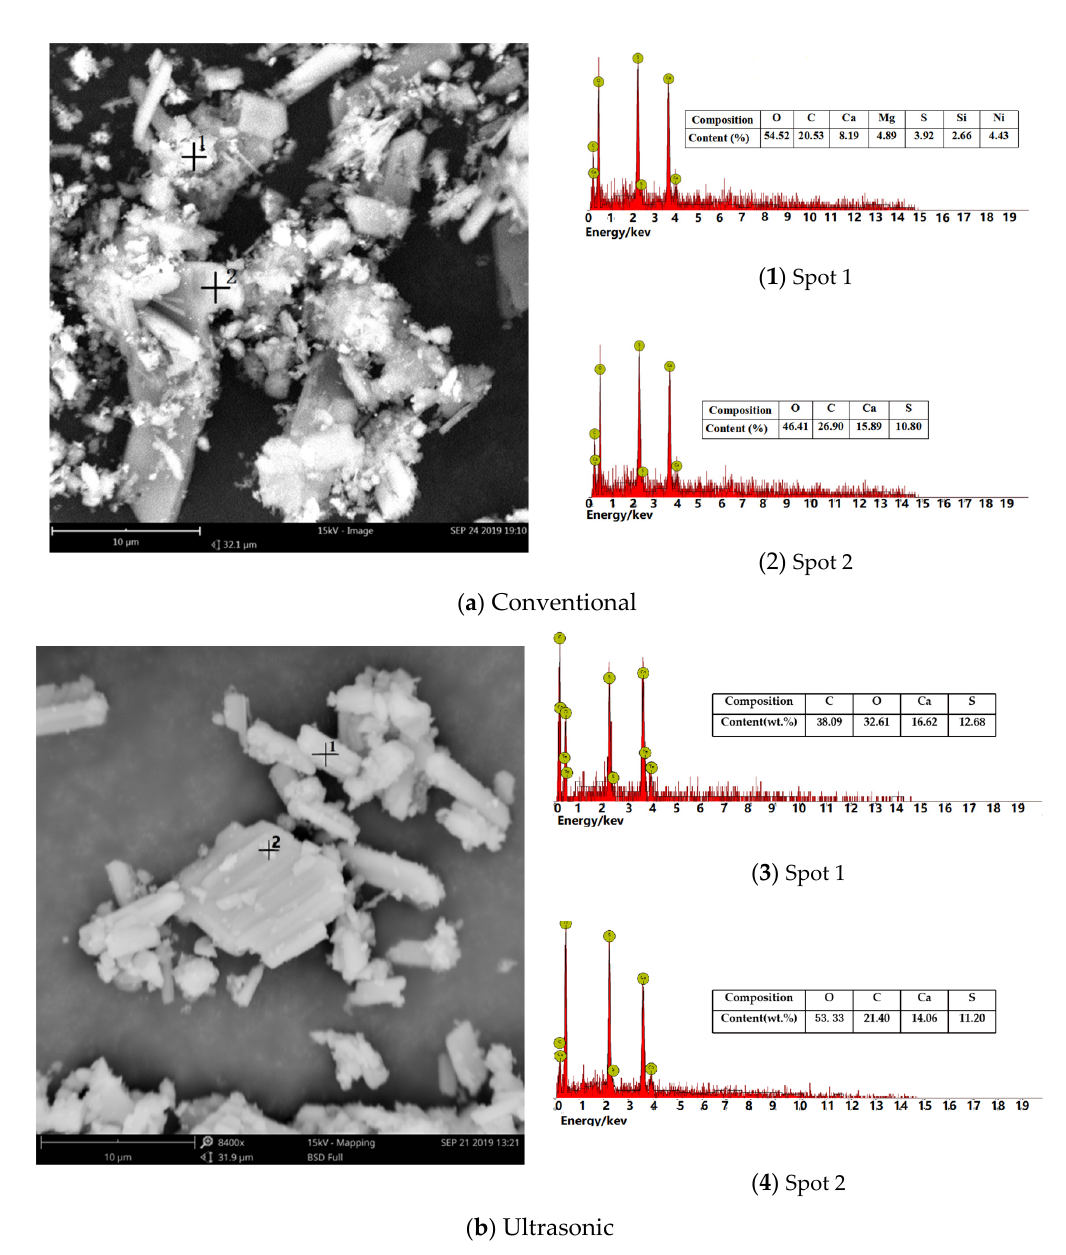
Figure 15. EDS analysis of the residue after leaching.